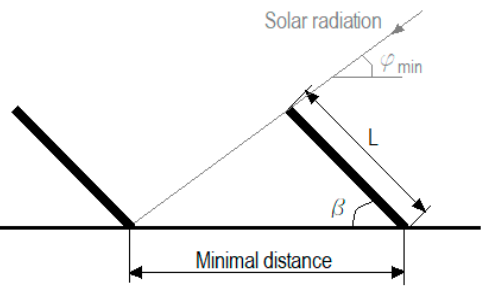
Figure 1. Diagram to calculate the minimum distance between collectors on a flat surface.